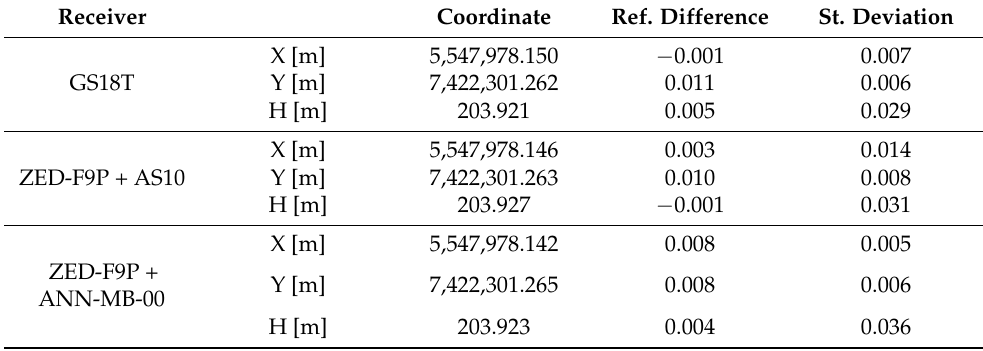
Table 5. Measurement results on Pt